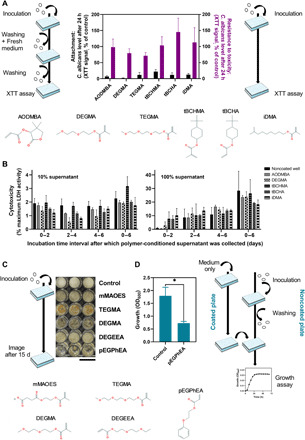
Anti-attachment versus growth inhibitory actions of selected materials.Schematics for assessing fungal attachment [(A), left] and growth inhibition [(A), right; (C); and (D)]. (A) Attachment and toxicity with C. albicans. Percentages were relative to noncoated control microplate wells. Differences between polymers were nonsignificant for either parameter [Tukey’s multiple comparisons by two-way analysis of variance (ANOVA)]. (B) CS from polymer-coated or uncoated wells was collected after the indicated incubation intervals [replacing with fresh Dulbecco’s modified Eagle’s medium (DMEM)] and added into 3T3 cell culture (10 or 100 μl). Lactate dehydrogenase (LDH) activity was assayed after 24 hours. Mean percentages ± SEM (n = 3) are relative to LDH release from lysed cells. There were no significant differences to CS from noncoated wells (Dunnett’s multiple comparisons by two-way ANOVA). TEGMA was excluded because polymer swelling complicated CS recovery. (C) B. cinerea cultivated for 15 days in polymer-coated 96-well plates. Scale bar, 1 cm. Polymerization tinted some materials. Photo credit: Cindy Vallieres, University of Nottingham. (D) Medium containing leached materials from pEGPhEA-coated or noncoated wells after 24 hours was transferred to wells containing B. cinerea spores preattached for 6 hours; then, growth was determined by OD600 after 24 hours (means ± SEM, n = 3). *P < 0.05 according to Student’s t test, two-tailed.